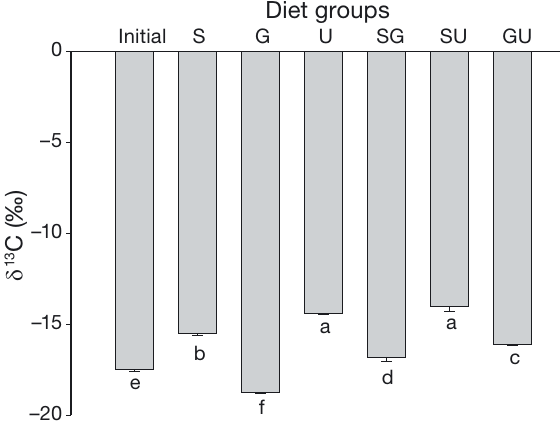
Fig. 1. Carbon stable isotope ratios ( δ 13 C) of sea cucumber Apostichopus japonicus at the beginning of the experiment (initial) and at the end of the experiment after feeding on dif- ferent diets. S: a diet of Sargassum muticum ; G: Gracilaria le- maneiformis ; U: Ulva lactuca ; S: a mixture of S. muticum and G. lemaneiformis ; SU: S. muticum and U. lactuca ; GU: G. le- maneiformis and U. lactuca . Error bars represent 1 SD (n = 3). Values with different letters represent significant differences (p <